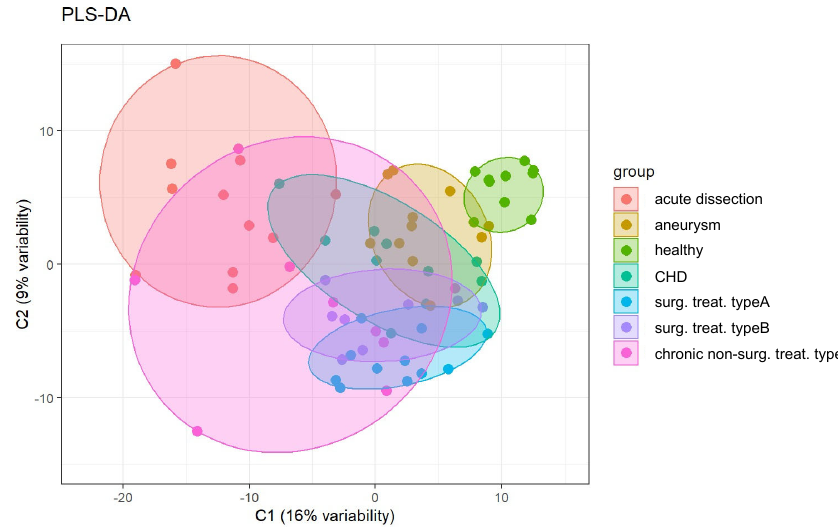
Figure 3. Partial least squares–discriminant analysis (PLS-DA) of the serum proteome profiles for the seven groups under investigation.